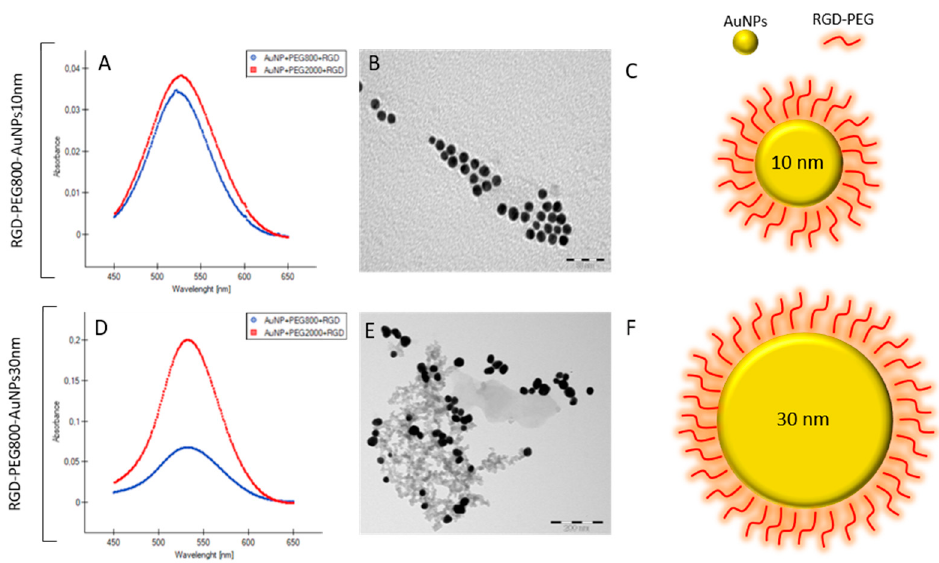
Figure 1. Characterization and morphology of the synthesized AuNPs. ( A ) UV–VIS spectrum for RGD-PEG 800 -AuNPs 10nm and RGD-PEG 2000 -AuNPs 10nm . ( B ) TEM image of 10 nm AuNPs, based on the TEM measurements the average size of AuNPs was 10.5 nm +/ − 1.3nm. ( C ) The scheme of RGD-PEG 800/2000 -AuNPs 10nm . ( D ) UV–VIS spectrum for RGD-PEG 800 -AuNPs 30nm and RGD-PEG 2000 -AuNPs 30nm . ( E ) TEM image of 30 nm AuNPs, based on the TEM measurements, the average size of AuNPs was 30.9 nm +/ − 1.8 nm. ( F ) The scheme of RGD-PEG 800/2000 -AuNPs 30nm .